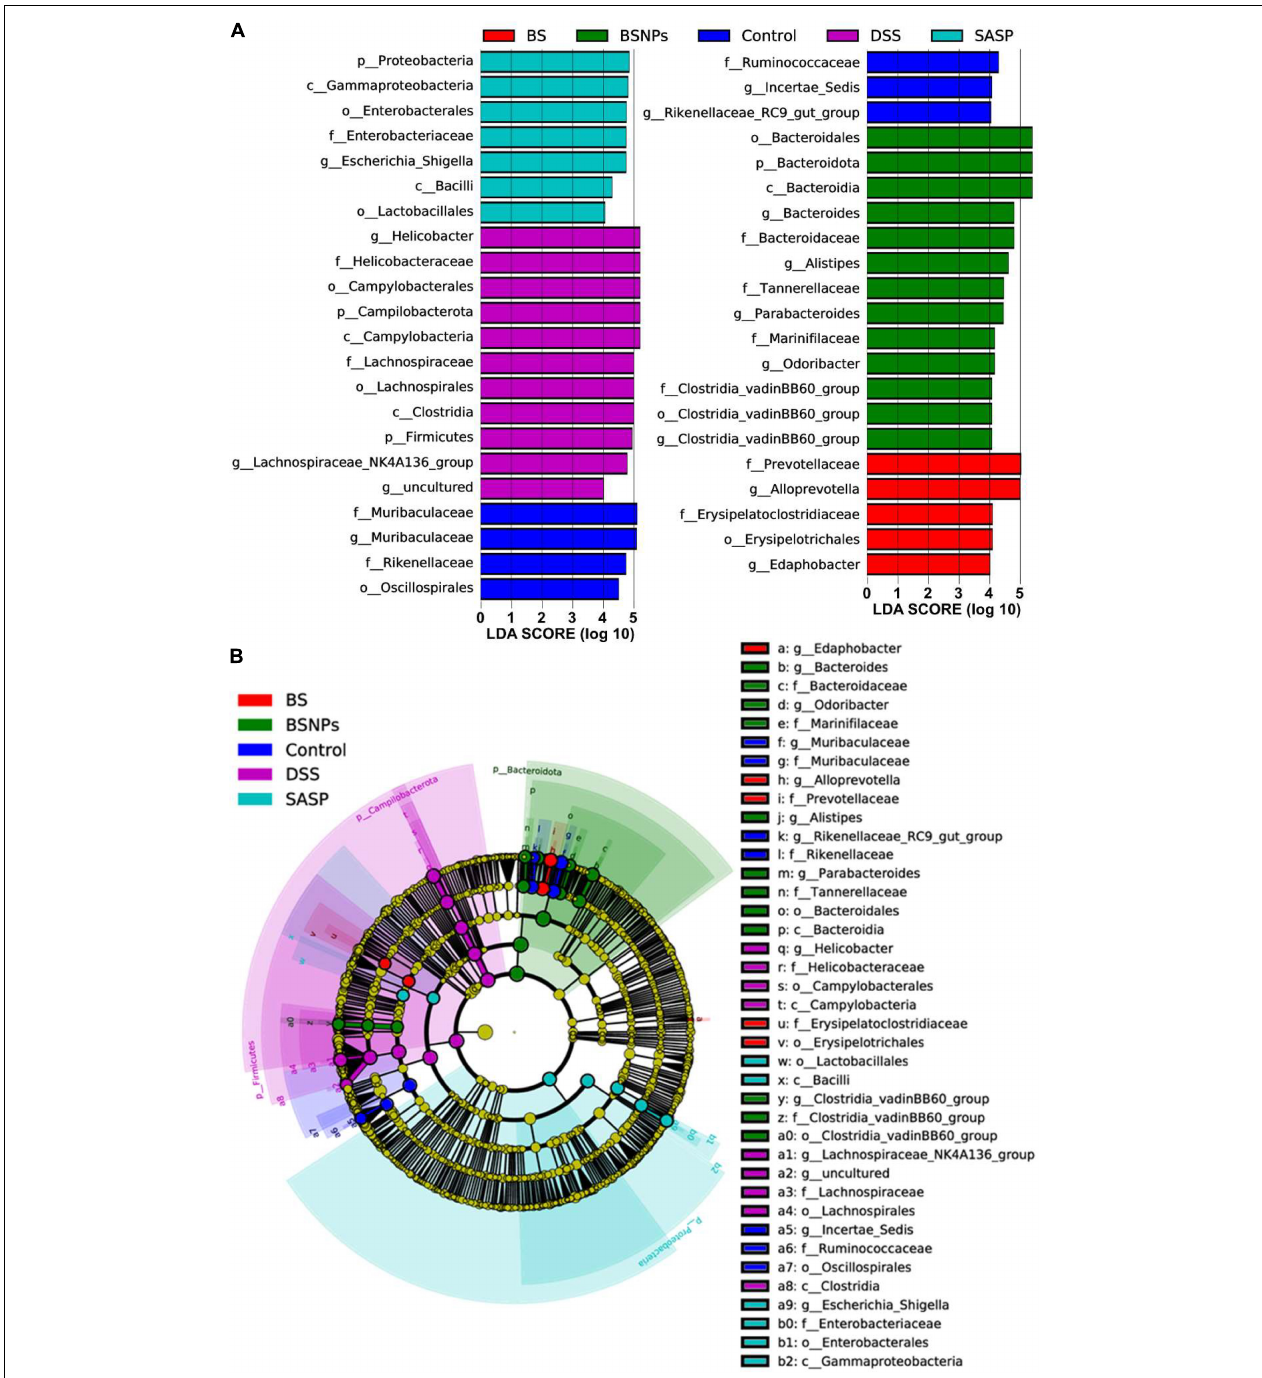
FIGURE 5 | Linear discriminant analysis (LDA) and effect size (LEfSe) analysis of bacterial among the different groups. (A) LDA indicates the most differential abundant bacterial taxa in specific samples. (B) Cladogram illustrating highly abundant taxa across various treatments.